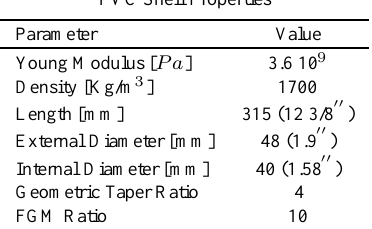
Table 1 PVC Shell